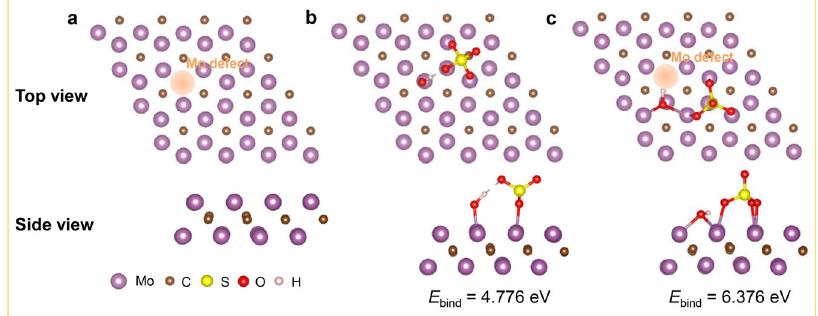
Fig. 5 The calculation of binding energy between Mo 2 C MXene/defective Mo 2 C MXene and peroxymonosulfate (PMS) based on density functional theory (DFT). a Structural optimization of Mo 2 C MXene with Mo-de fi cit vacancy defects. b Combination between Mo 2 C MXene and PMS. c Combination between Mo 2 C MXene with Mo-de fi cit vacancy defects and